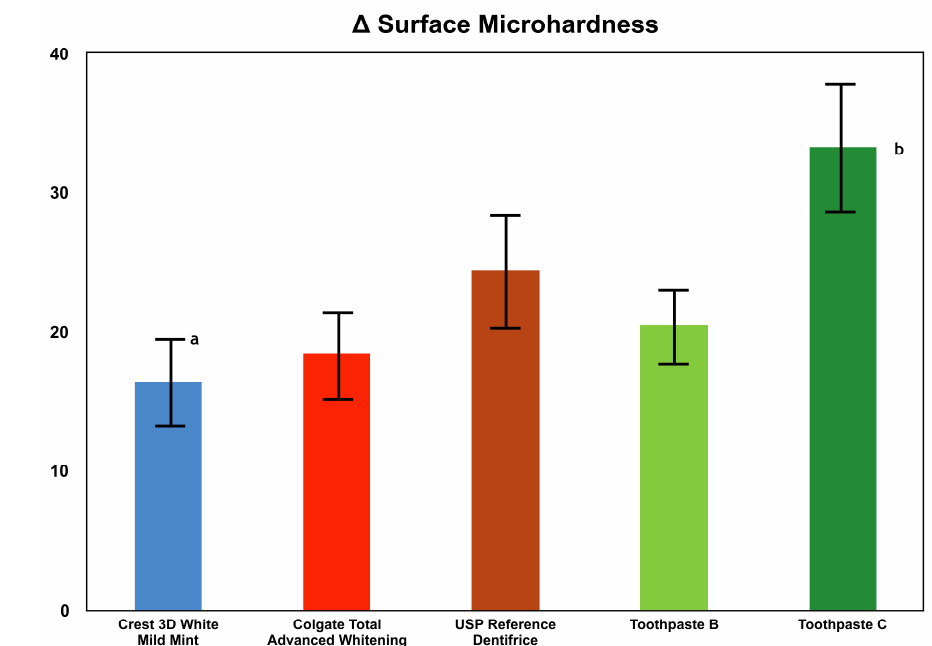
Figure 2. Comparison of ∆ surface microhardness after 20 days of remineralization treatment between Crest 3D White Mild Mint, Colgate Total Advanced Whitening, USP Reference Dentifrice, Toothpaste B, and Toothpaste C. a Brackets represent two standard deviations, mean ± one standard deviation. b Significant difference, p < 0.001, large effect size for Toothpaste C over all others with Cohen’s d : 1.64.